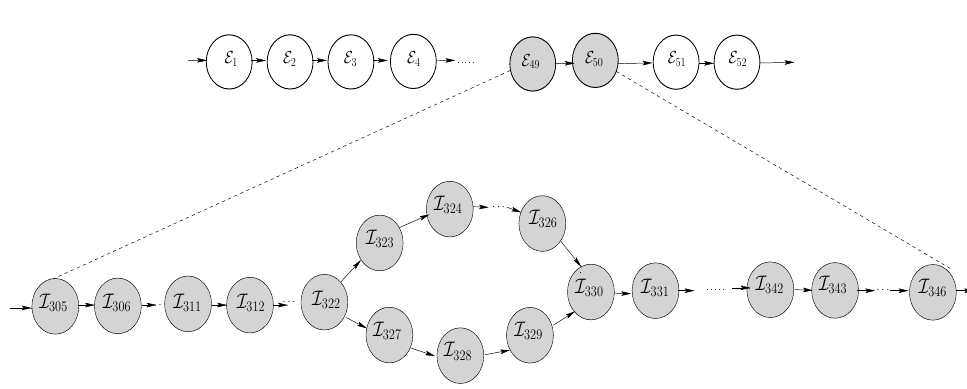
Figure 7: Control flow graph G ( V , E ) corresponding to the IR instruction for program expressions E 49 , E 50 given in Figure